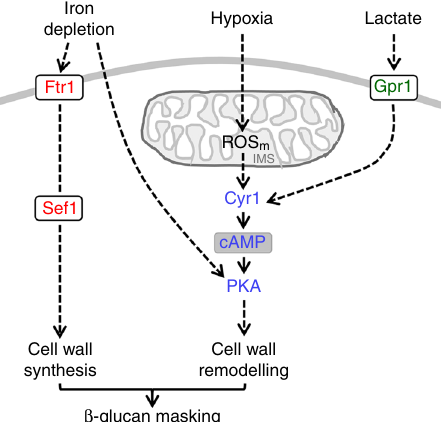
Fig. 10 Different input-speci fi c signalling pathways activate β -glucan masking. Protein kinase A (PKA) signalling is required for iron limitation- induced, hypoxia and lactate-induced β -glucan masking 28 (Fig. 6). However, masking in response to iron limitation is not dependent upon adenylyl cyclase (Fig. 6a), unlike lactate-induced (Fig. 6b) or hypoxia- induced β -glucan masking 28 . Regarding the upstream signalling modules, iron limitation activates β -glucan masking via the iron transceptor Ftr1 and the iron responsive transcription factor Sfe1. In contrast, lactate triggers β - glucan masking via the receptor, Gpr1 (ref. 27 ) and the hypoxia signal appears to be transduced via mitochondrial ROS signalling 28 . Hypoxia- induced mitochondrial ROS signalling seems to lie upstream of PKA signalling 28 . In contrast, iron-related Ftr1-Sef1 signalling appears to act independently of PKA signalling (Fig. 9). Since PKA signalling is not required for cell wall elaboration or growth under iron-limiting conditions (Fig. 9b – d) this pathway might promote β -glucan masking via cell wall remodelling mechanisms that remain to be de fi ned. Ftr1-Sef1 signalling is required for cell wall elaboration and growth under iron limitation (Fig. 9c, d) and therefore might promote β -glucan masking by driving the synthesis of a relatively thick outer mannan layer (Figs. 4, 9). Source data are provided as a Source Data fi